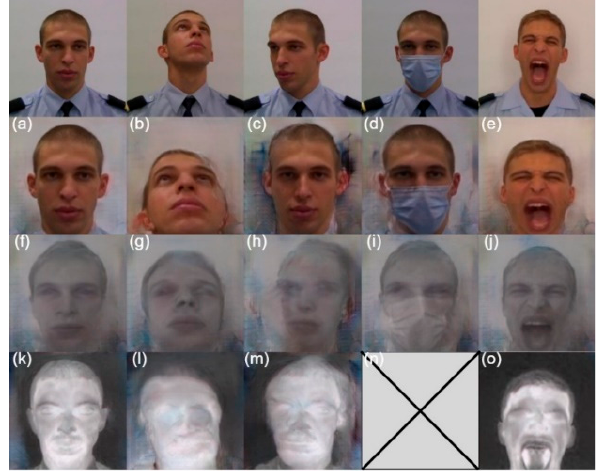
Figure 10. Results achieved by the FFWM in the different spectral bands. The images on the top are the originals in the VIS. The images ( a – e ), ( f – j ), and ( k – o ) were generated by the proposed methodology when it receives as input the images from the VIS, NIR and LWIR bands, respectively.